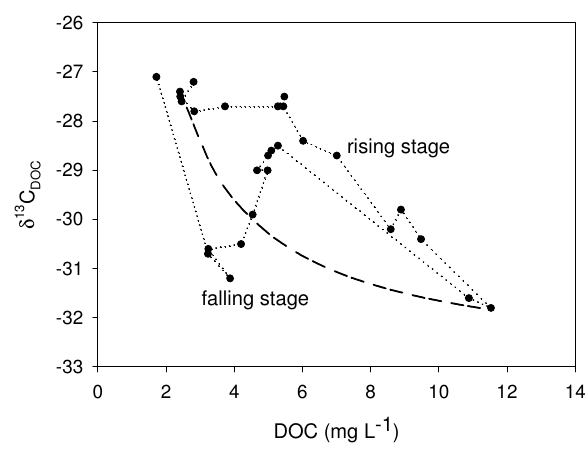
Fig. 10. Covariation between dissolved organic carbon concentra- tions the stable carbon isotope composition of DOC. Dotted lines connect data from subsequent sampling dates, curve represents a theoretical 2-source mixing scenario (see text for